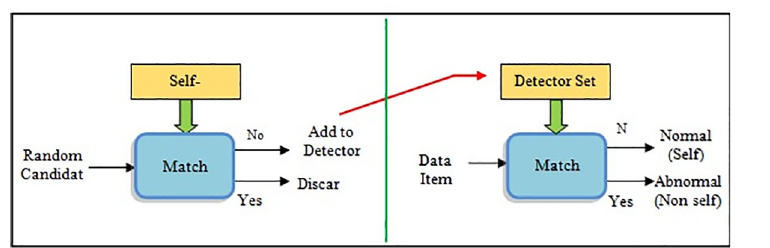
Fig 1. Negative Selection Algorithm (NSA)